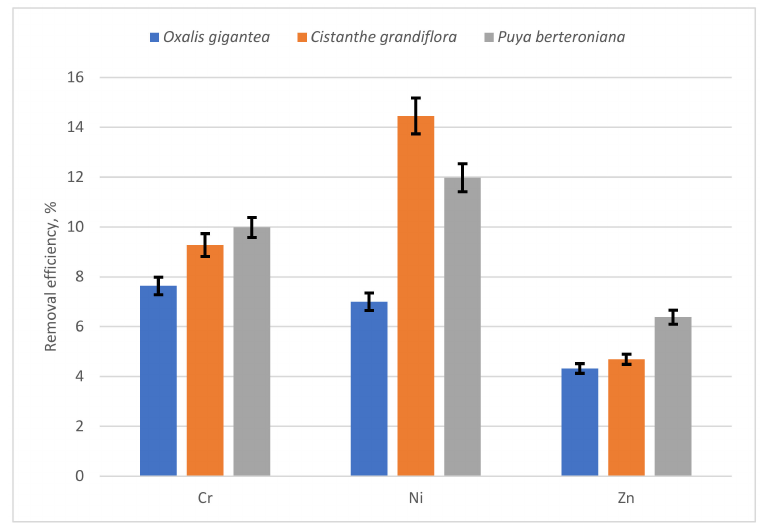
Figure 4. Removal efficiency ± standard deviation for Ni, Zn, and Cr for all studied